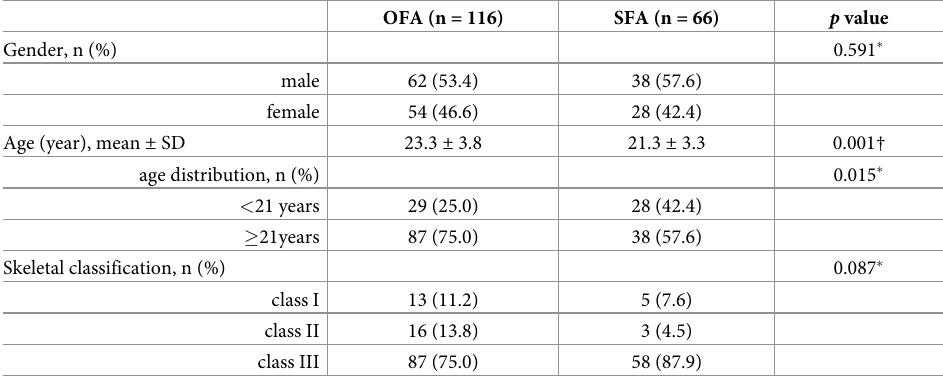
Table 1. Demographic and clinical characteristics of study